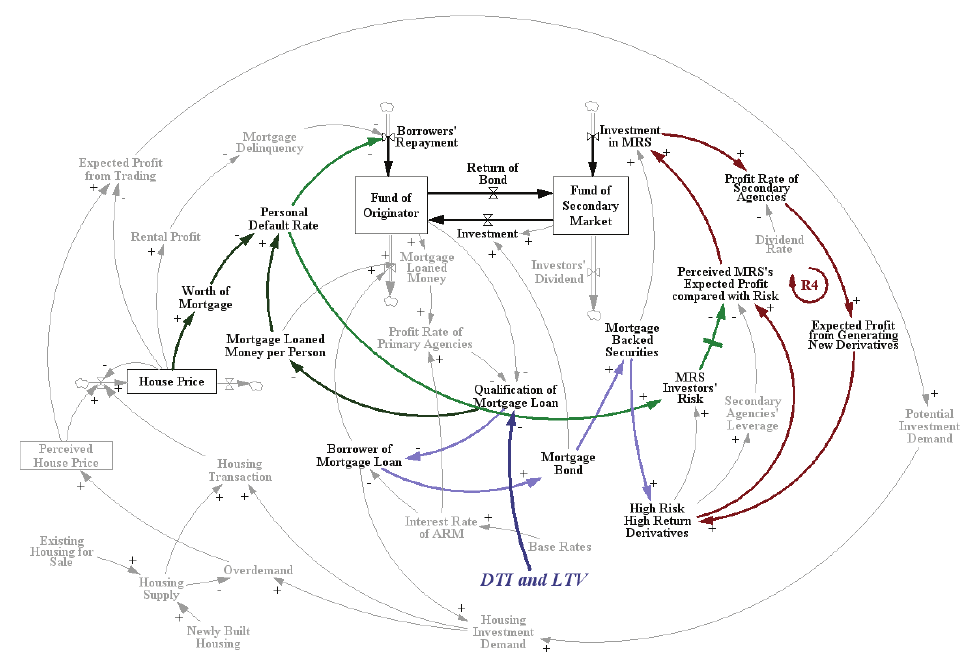
figure 11. forecasted side effects of